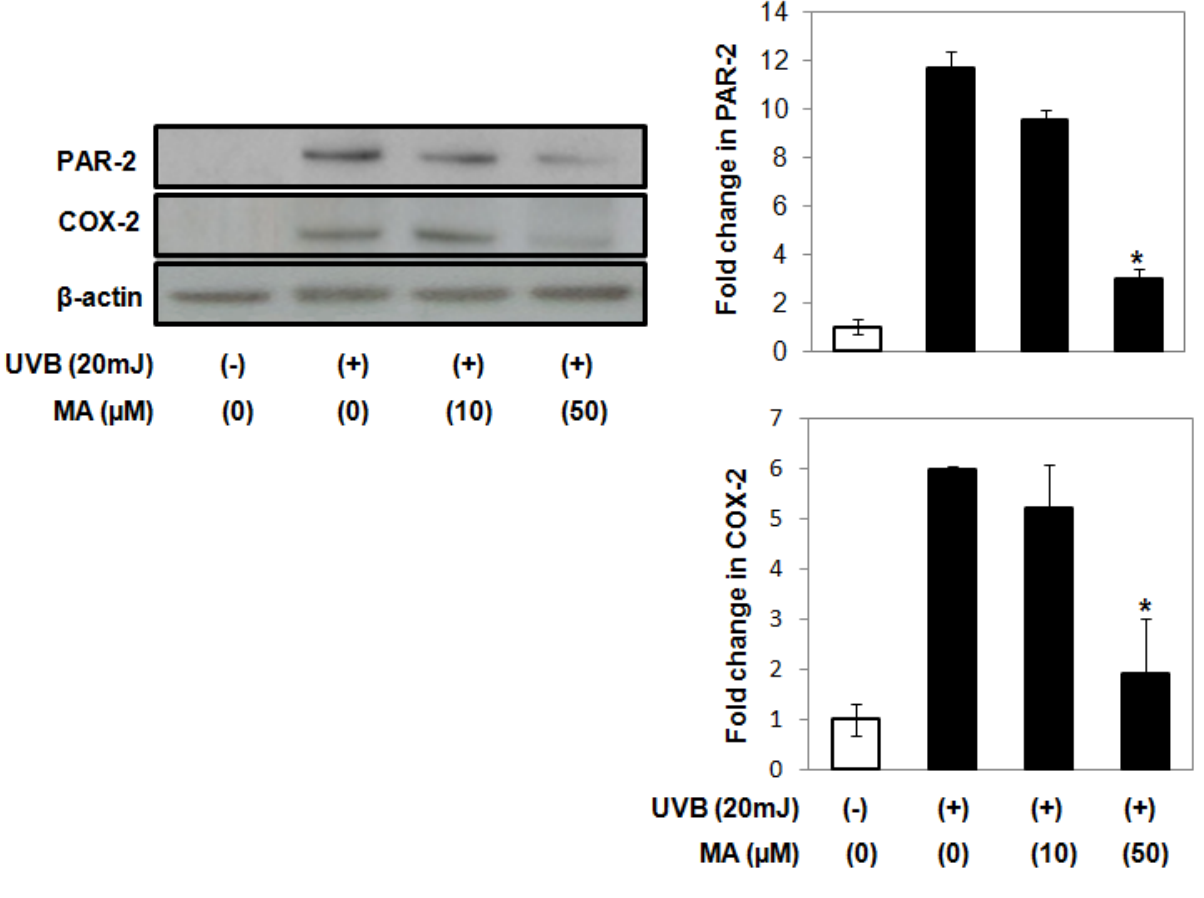
Figure 3. Effect of MA on COX-2 and PAR-2 expression in keratinocytes. Proteins were extracted from whole cell lysates of HaCaT keratinocytes. β -actin was used as a loading contril. The data shown are the mean ± S.D., n = 3; * p < 0.05 vs. UVB-irradiated control; MA: